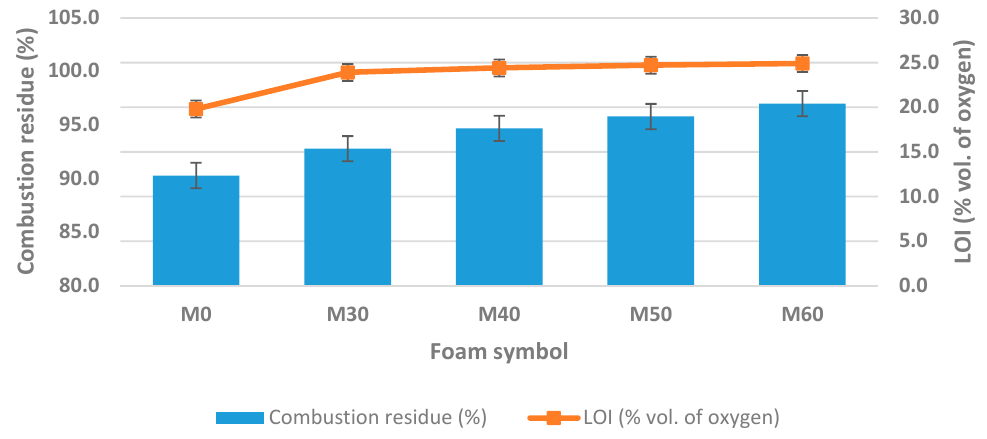
Figure 7. Dependence between content of rapeseed cake, combustion residue and limited oxygen index (LOI).